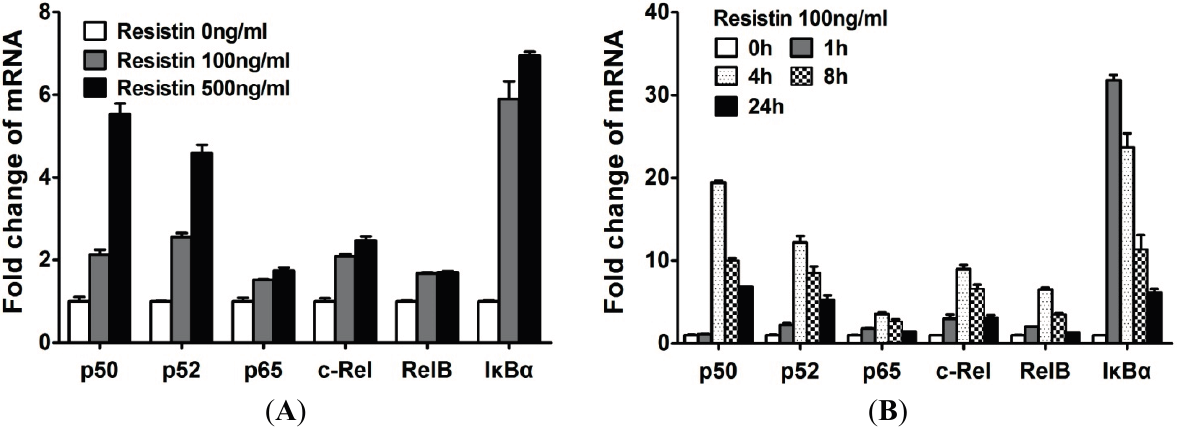
Figure 3. Resistin stimulates the expression of NF- κ B isoforms in normal human articular chondrocytes (HACs). The relative expression levels were examined in normal chondrocytes from human articular cartilage treated with resistin for various doses and times using quantitative real time PCR method. ( A ) Cells were treated with various concentrations of resistin for 24 h as indicated in HACs; ( B ) Cells were treated with 100 ng/mL resistin for various times as indicated in HACs. Each bar represents the mean ± S.D. from three